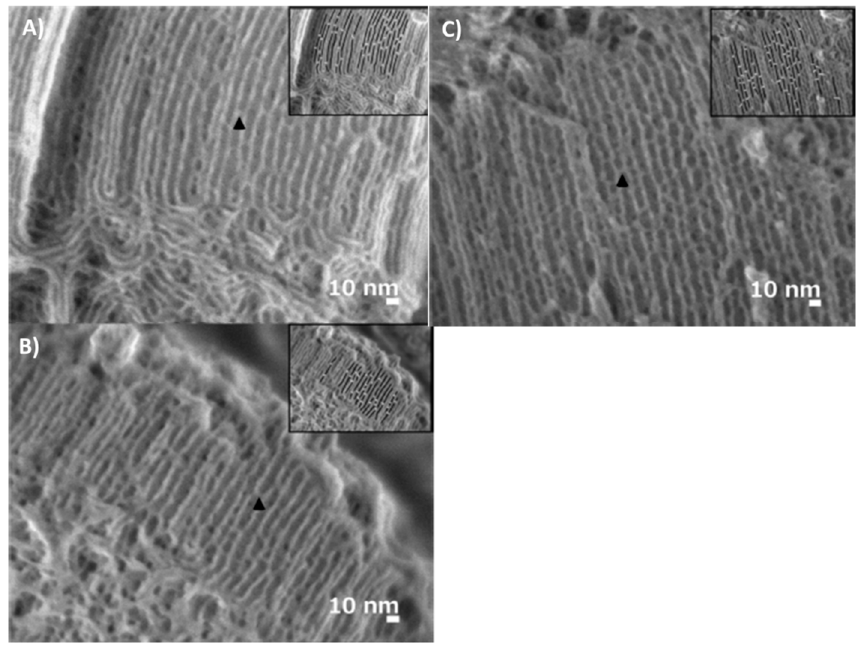
Figure 8. LV-HRSEM images of plugged SBA-15 obtained under different conditions of ( A ) NaCl-0.5 M, ( B ) SBA-15-ref, and ( C ) EtOH-0.5 M. The black arrows show examples of plugs. The inset shows the same image after the analysis, with the pores marked in black and plugs in white. Images were taken with a landing energy of 300 eV after applying a specimen bias of 5 kV [54].